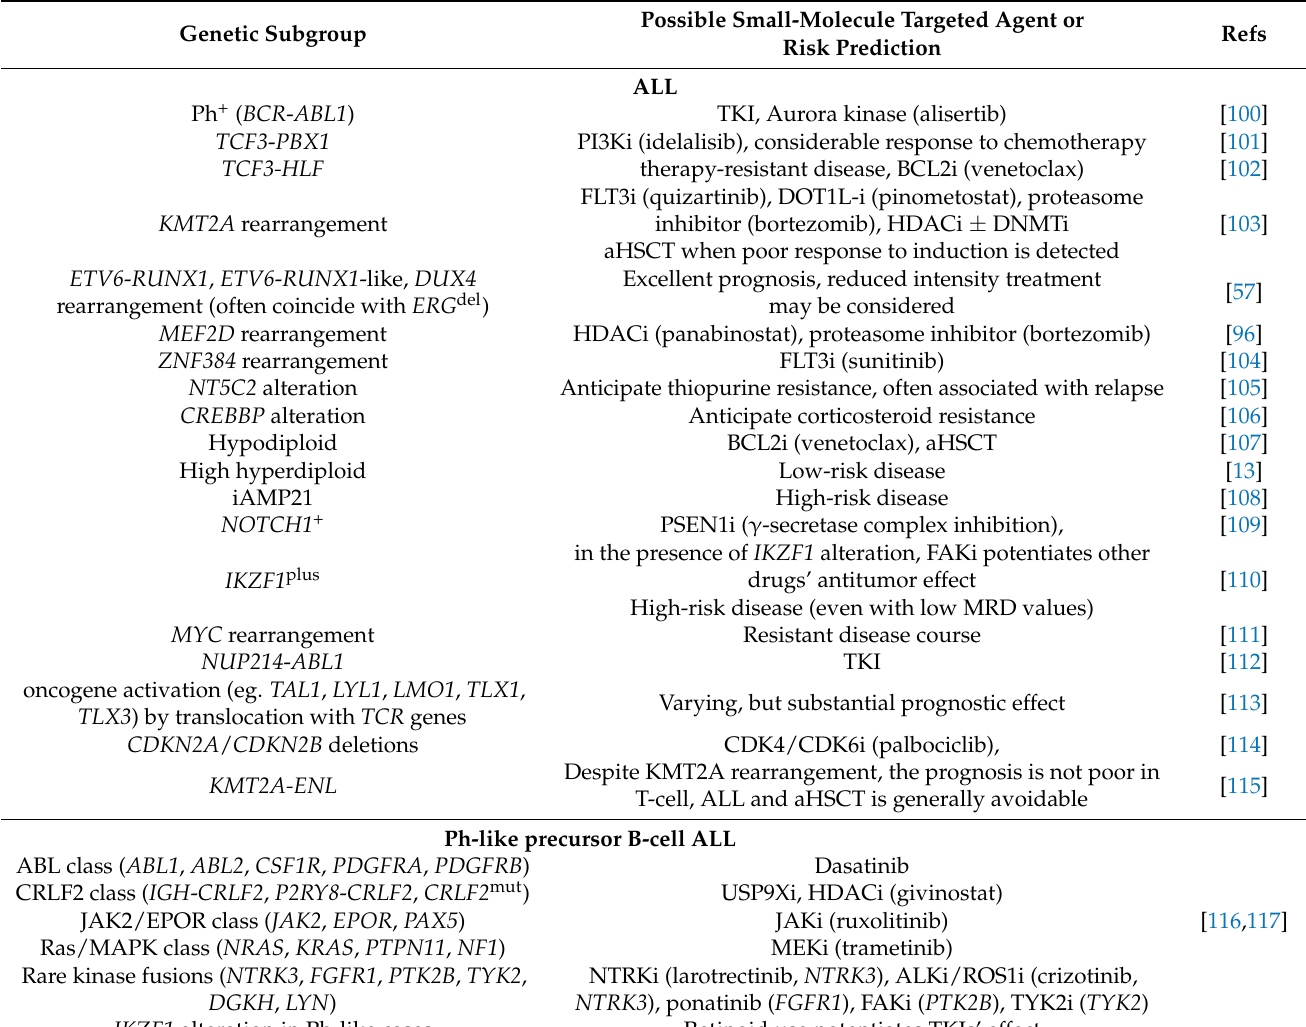
Table 1. Genetic subgroups as indication criteria for small-molecule targeted agents and guide for patient stratification in pediatric acute